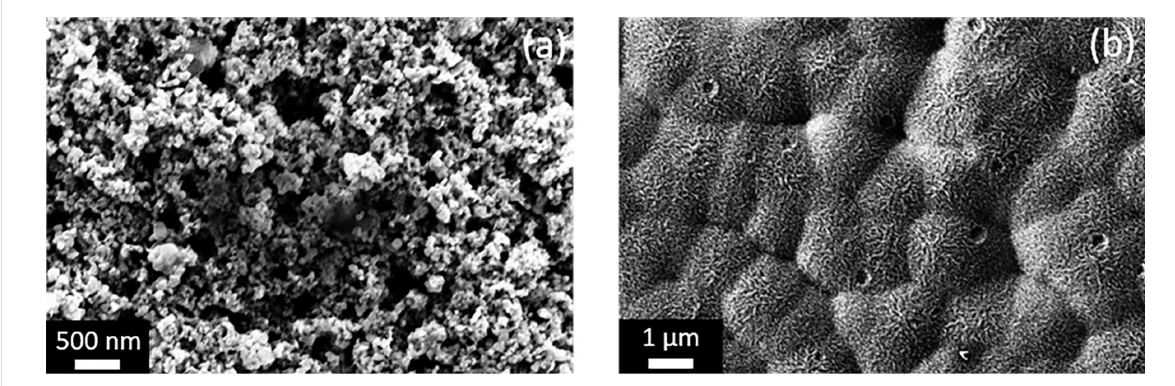
Figure 5: FE SEM images of (a) CoFe 2 O 4 nanoparticles and (b) PVDF-TrFe/CoFe 2 O 4 with 5 wt % of CoFe 2 O 4 .